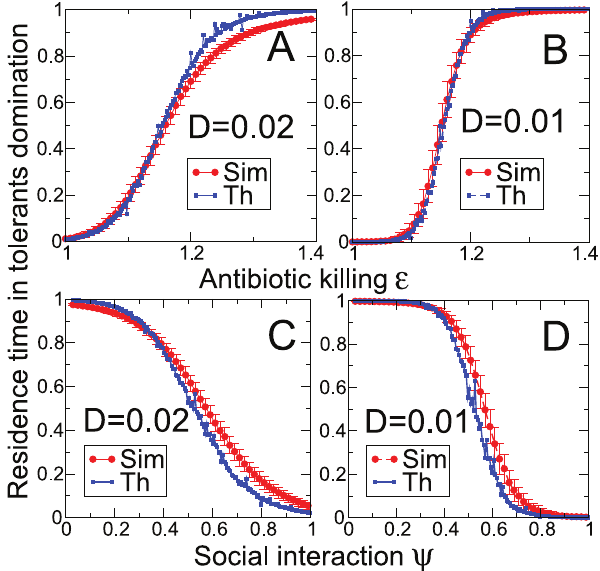
Figure 4. Microbiota resident time in antibiotic-tolerant domination as a function of the: A–B) antibiotic action ( E ) and C–D) social interaction ( y ) parameters. Blue circles show the theoretical predictions obtained by determining the probability of the most probable path. Red circles are obtained by simulating the Langevin dynamics over 10000 iterations and averaged for 1000 noise realizations. Higher order-corrections can be included to increase the theoretical estimation